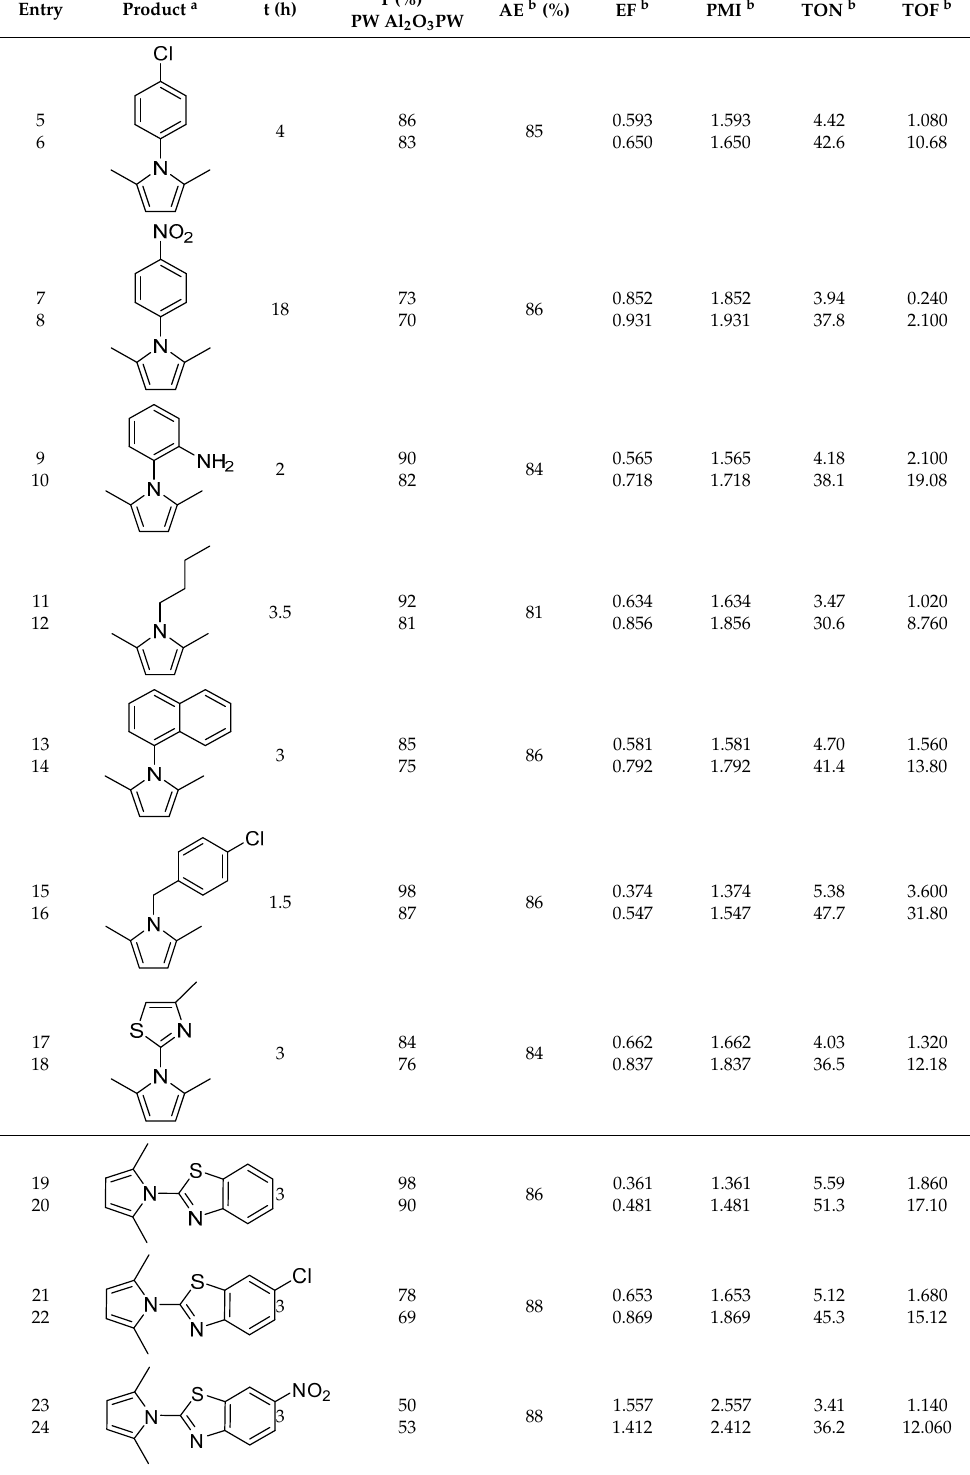
Figure 8. Radial pentagon for the tandem reaction in chromene–pyrrole synthesis. Also, the bifunctional characteristics of these new materials allowed us to carry out a tandem synthesis of pyrroles that involves the initial formation of 2-amino-3-cyano-4-H-chromenes by a multicomponent reaction between benzaldehyde or 4-methylbenzaldehyde, malononitrile, and 2- naphthol, and their subsequent conversion to pyrrole using acetylacetone as reagent (Scheme 3), which requires catalysts with dual characteristics (acid–base). Two new compounds with good selectivity can be obtained by this process. The two products obtained were characterized by mass spectrometry. They are unstable and decompose during their purification, and for that reason, it was impossible to determine their NMR spectra. Scheme 3. Multicomponent synthesis of chromene–pyrroles. Based on the literature consulted, we propose a plausible mechanism for the synthesis of these chromene–pyrroles comprising two steps (Scheme 4): a first step in which the multicomponent